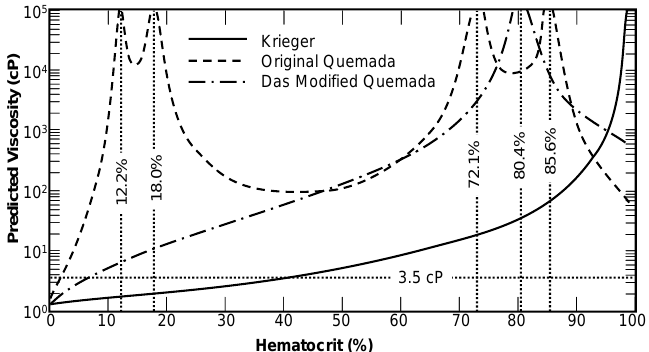
Figure 1. The zero-shear viscosity prediction of the original Quemada model, the modified Quemada model, and the Krieger model with n = 2. Discontinuities and regions where the viscosity is inversely proportional to hematocrit were found for both forms of the Quemada model.